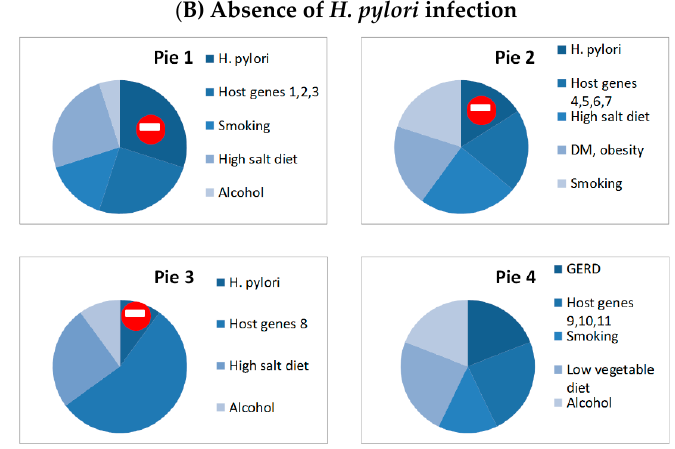
Figure 2. The causal pie model—role of H. pylori in gastric carcinogenesis. H. pylori : Helicobacter pylori ; DM: diabetes mellitus; GERD: gastroesophageal reflux disease.